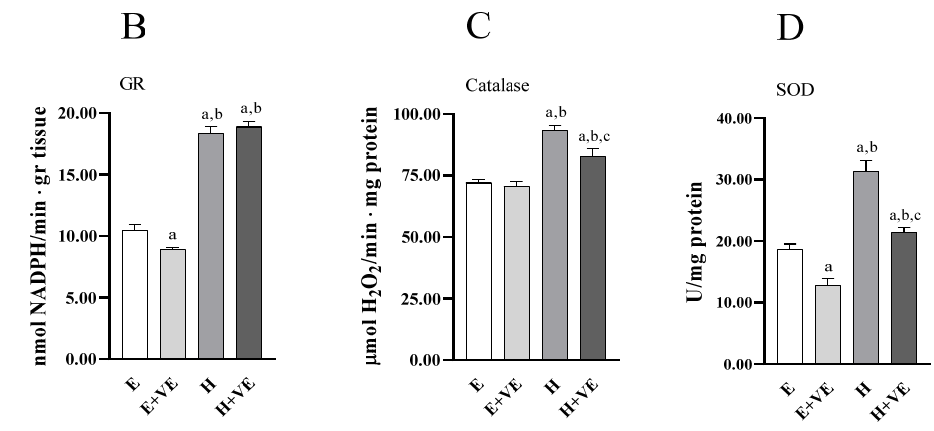
Figure 4. Antioxidant enzyme activities. GPX ( A ), GR ( B ) catalase ( C ), and SOD activity ( D ) in liver from E, E + VE, H and H + VE rats. Values are means ± SEM of eight determinations from different rats. Each determination is the mean of three independent measures. E, euthyroid; E + VE, euthyroid fed vitamin E supplemented diet; H, hyperthyroid; H + VE, hyperthyroid fed vitamin E supplemented diet. a significant vs. E. b significant vs. E + VE. c significant vs. H. The level of significance was chosen as p <